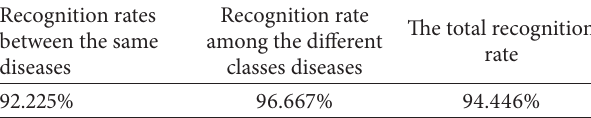
Table 1: Maize leaf disease recognition accuracy (%). Recognition rates Recognition rate between the same among the different diseases classes